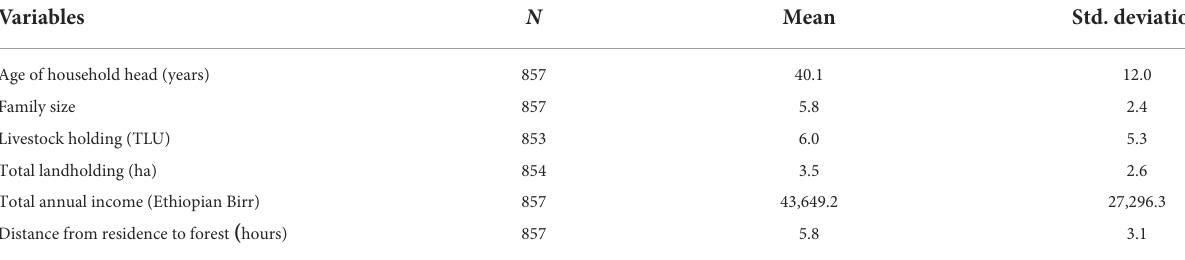
TABLE 3 Description of continuous socio-economic variables of